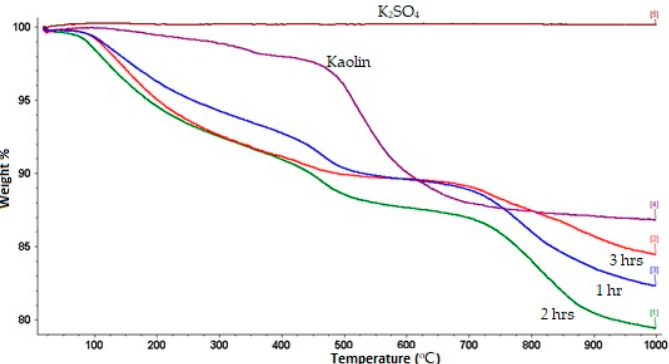
5 of 10 Figure 2. XRD patterns of kaolinite-K 2 SO 4 system milled at speed 700 rpm for 120 min.